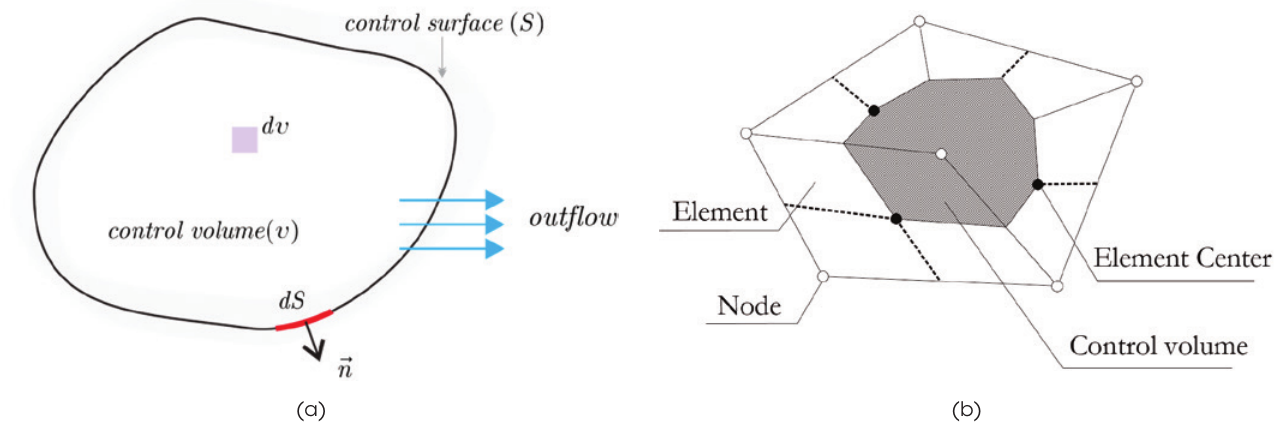
Control volume 2D: (a) Fluid flowing through the generic control volume; (b) Typical mesh for a generic control